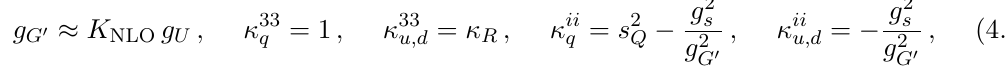
Figure 13 . Collider constraints from resonant G 0 production with dijet (green) and t ¯ t (blue) final states for the benchmark couplings κ ii in both cases (see text for details). We mark in gray those values of the width which are below the sum of t ¯ t and dijet partial widths for g